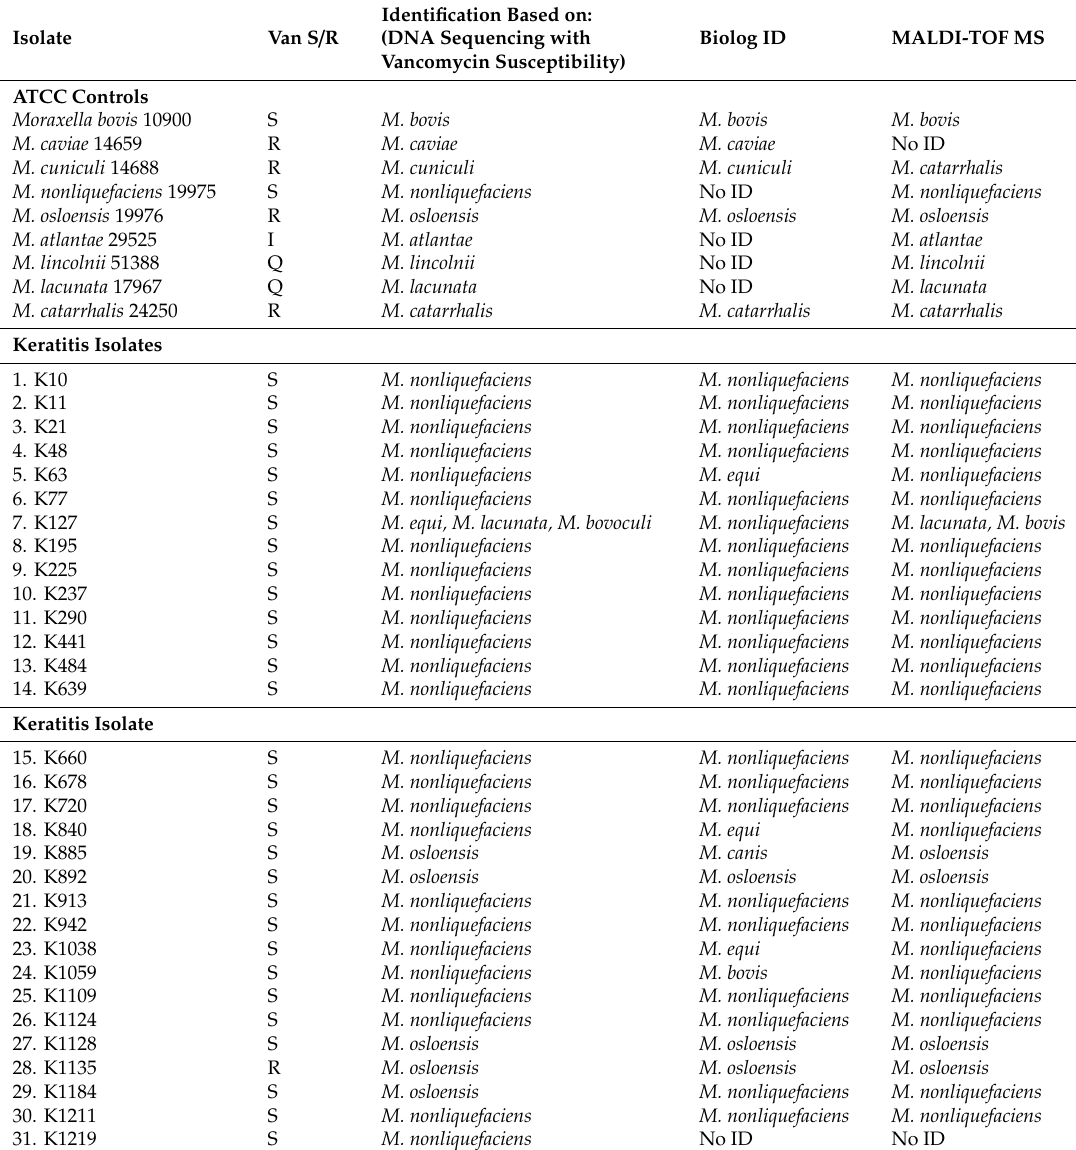
Table 1. Identification of Moraxella species from keratitis, conjunctivitis, and endophthalmitis using DNA sequencing, Biolog, and MALDI-TOF MS. Identification Based on: Isolate Van S / R (DNA Sequencing with Biolog ID MALDI-TOF MS Vancomycin Susceptibility) ATCC Controls Moraxella bovis 10900 S